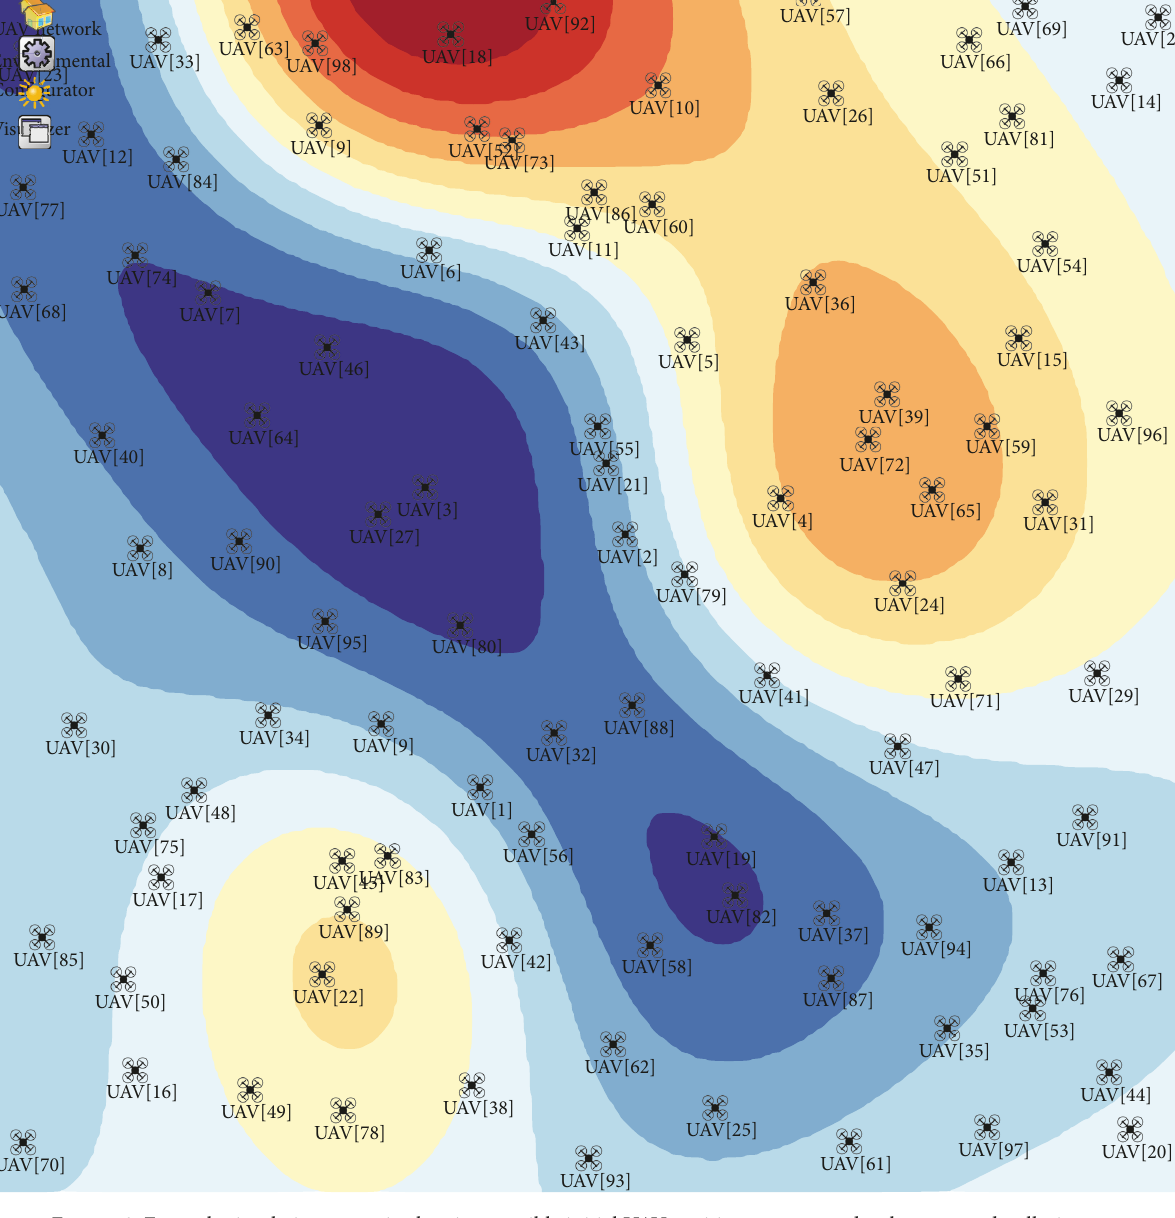
random data sources of ozone concentration. The